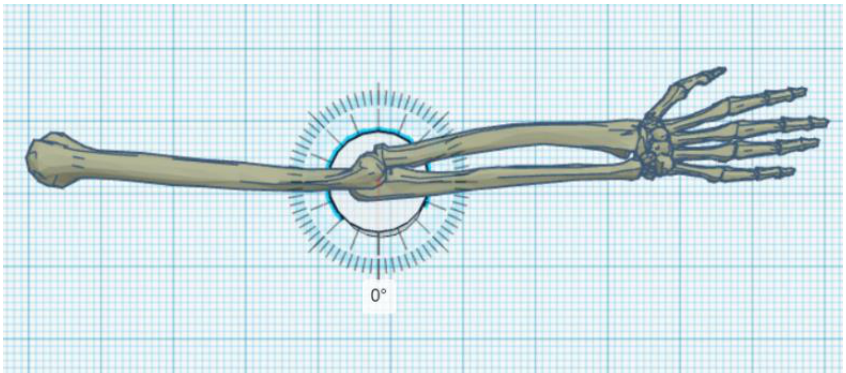
Figure 1. Supported elbow movements [26].